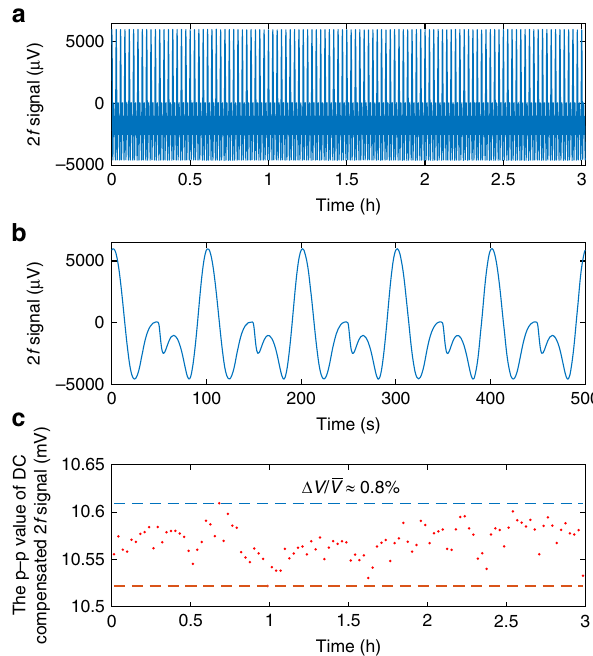
Fig. 5 Results of long-term stability test. a , b 2 f signal a over a period of 3 hours and b from 0 to 500 s. c The variation of p – p value of DC compensated 2 f signal over 3 hours.